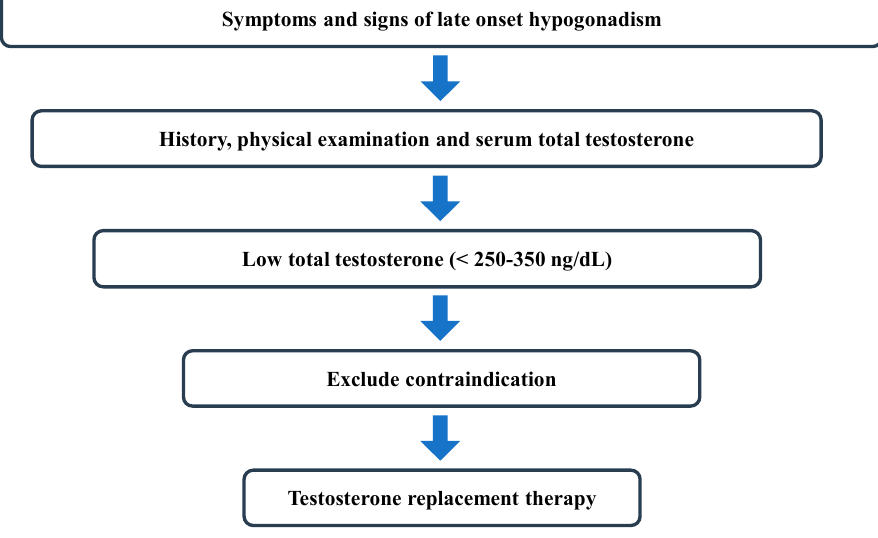
Figure 1. Flowchart for the management of late-onset hypogonadism.